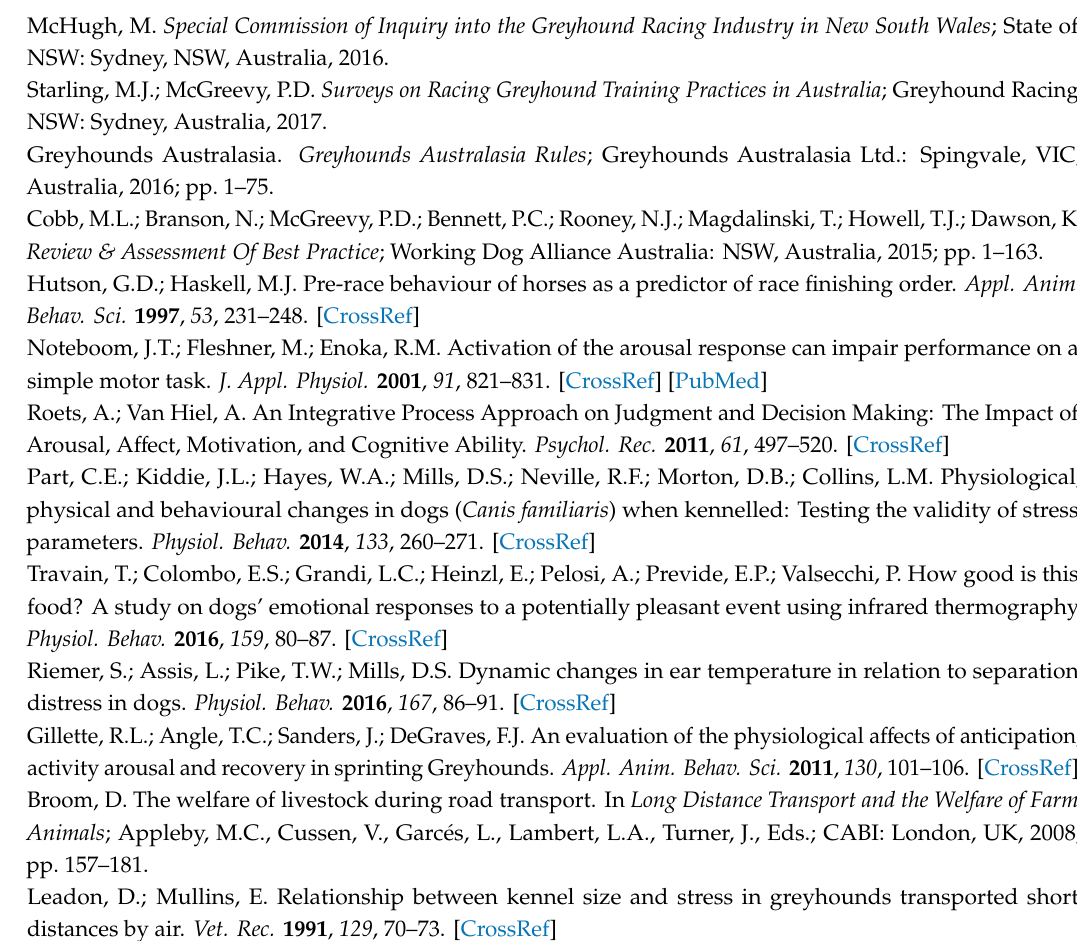
Figure S1: Configurations of the three tracks in the study. (a) Kennel block; (b) stir-up yard; (c)